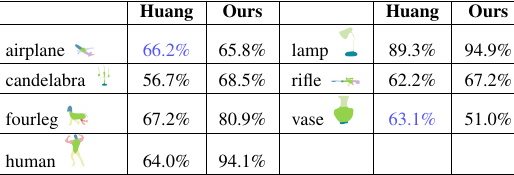
Table 4: Comparision with Huang et al. [2014] in precision.